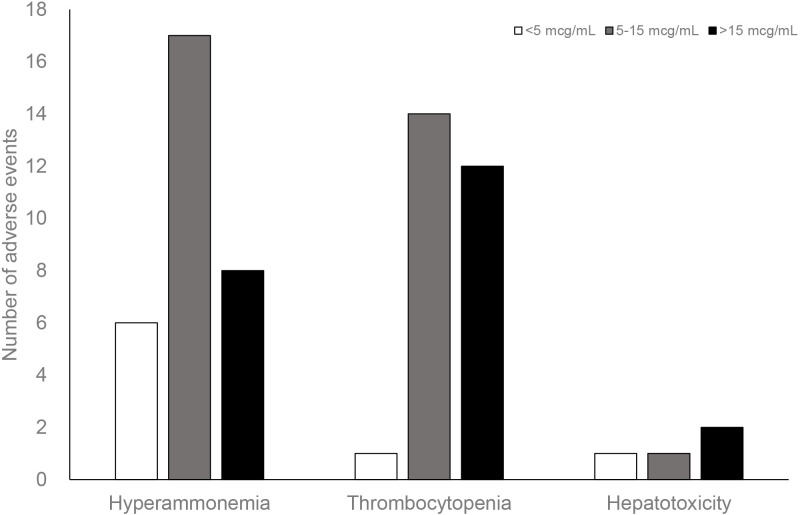
Distribution of free serum concentration to valproic acid–associated adverse effects.